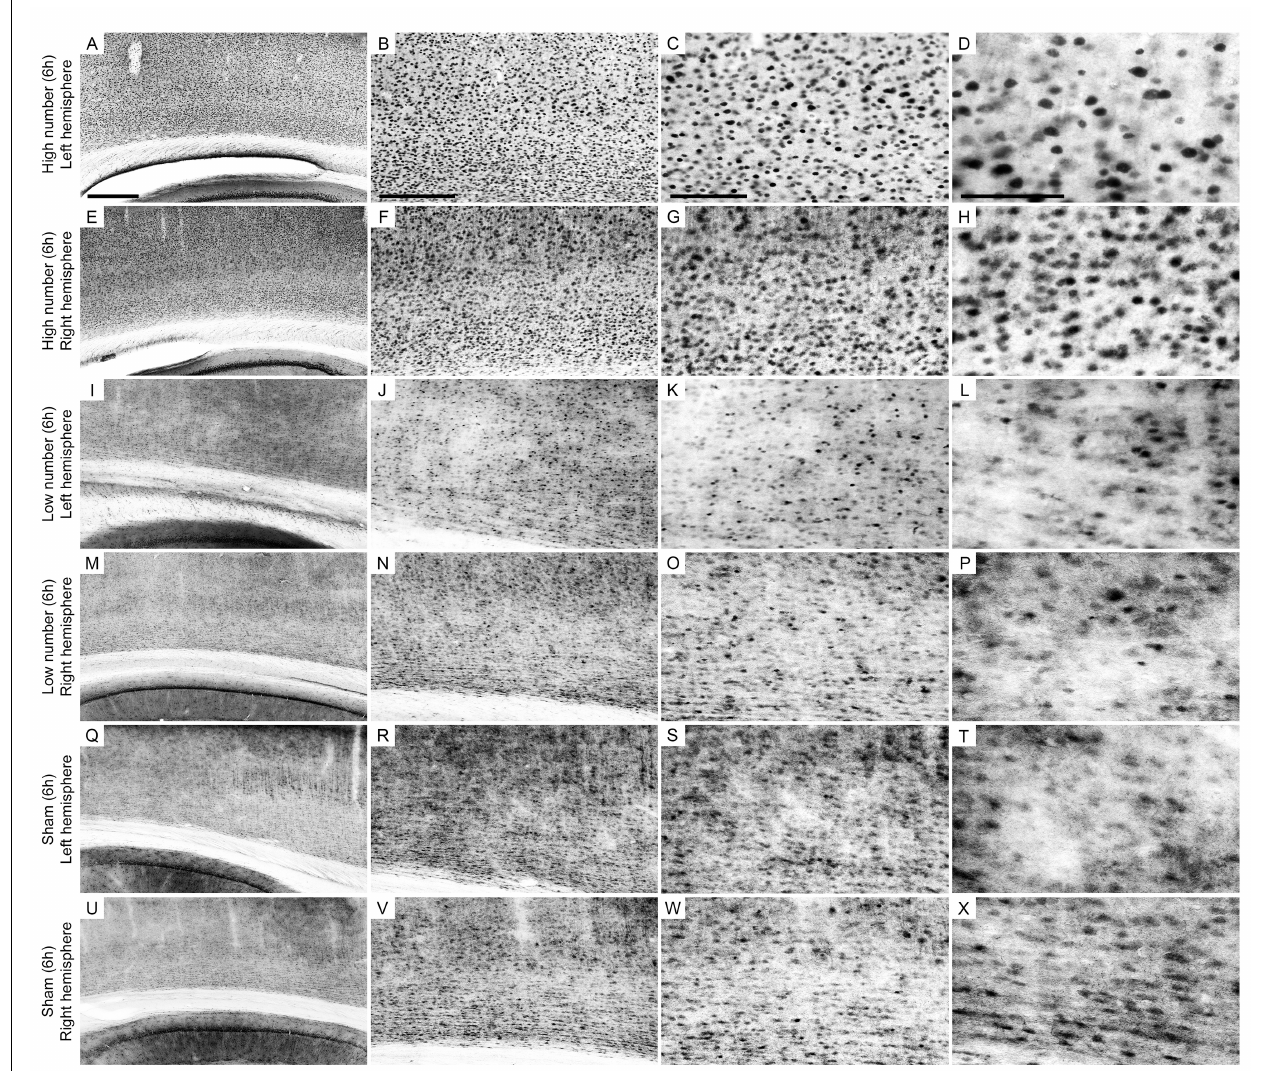
FIGURE 5 | Low-power and high-power photomicrographs of the infragranular somatosensorial (ss) cortical layers in the indicated 6 h recording groups. The sections that were immunolabeled with anti-Egr-1 antibody showed qualitative differences between the 6 h recording groups: high number of CSD episodes in the left/ipsilateral hemisphere (A–D) ; high number of CSD episodes in the right/contralateral hemisphere (E–H) ; low number of CSD episodes in the left/ipsilateral hemisphere (I–L) ; low number of CSD episodes in the right/contralateral hemisphere (M–P) ; sham left/ipsilateral hemisphere (Q–T) ; and sham right/contralateral hemisphere (U–X) . Scale bars in panels (A,E,I,M,Q,U) = 500 µ m; in panels (B,F,J,N,R,V) = 300 µ m; in panels (C,G,K,O,S,W) = 150 µ m; and in panels (D,H,L,P,T,X) = 100 µ